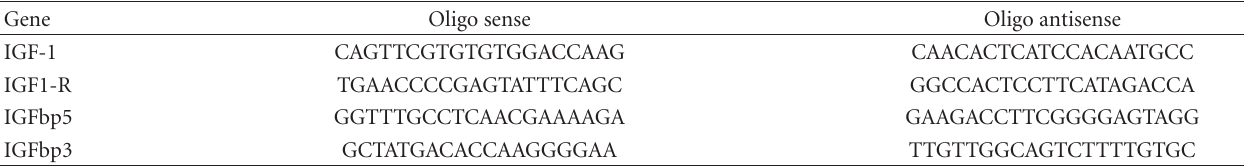
Table 1: Detailed description of the oligos (sense/antisense) used to amplify genes of interest. Gene Oligo sense